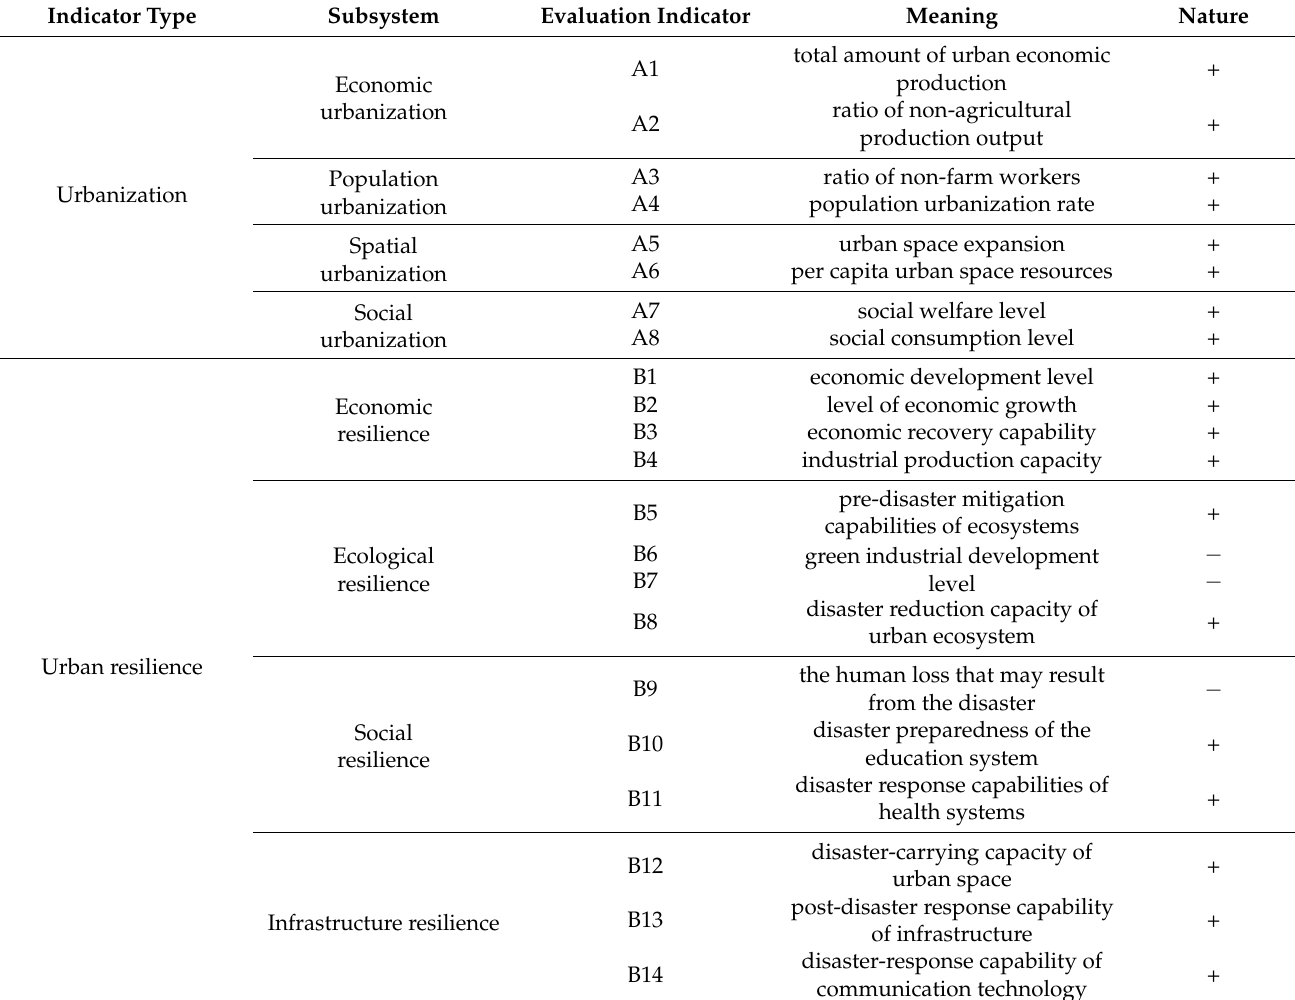
Table 3. Evaluation index system for urbanization and urban